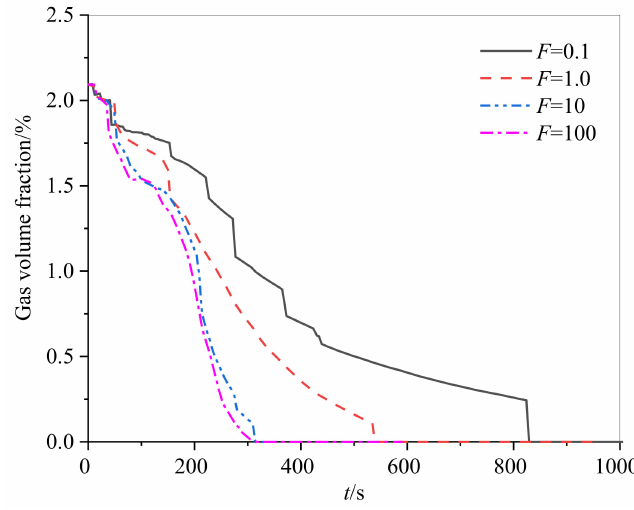
Figure 2. Influence of relaxation parameter F on simulated calculation ( m = 0.2 kg/s, ∆ T sub = 1 K).